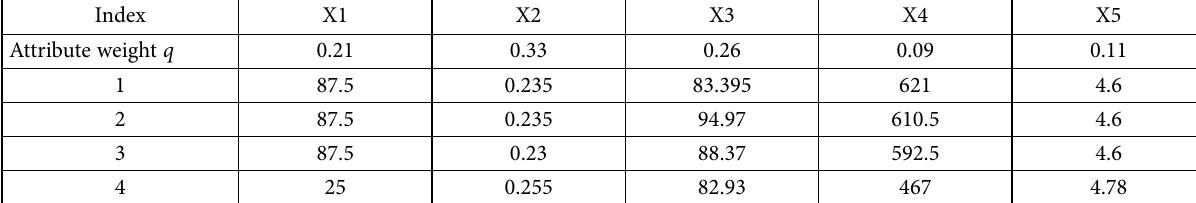
Table 2. Arithmetic mean value of decision-making